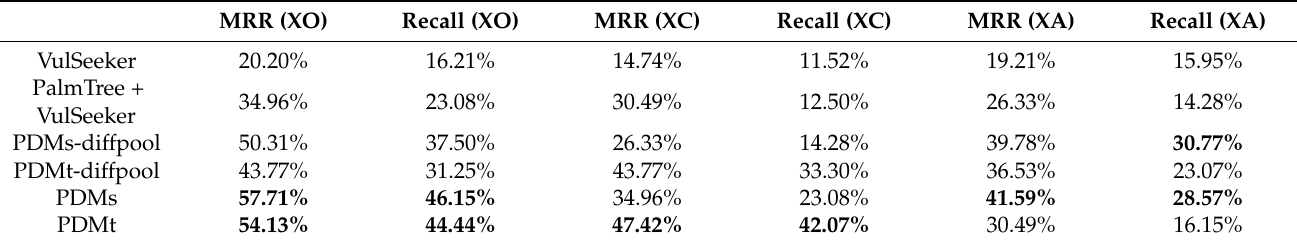
Table 2. Accuracy in conditions XO, XC, and